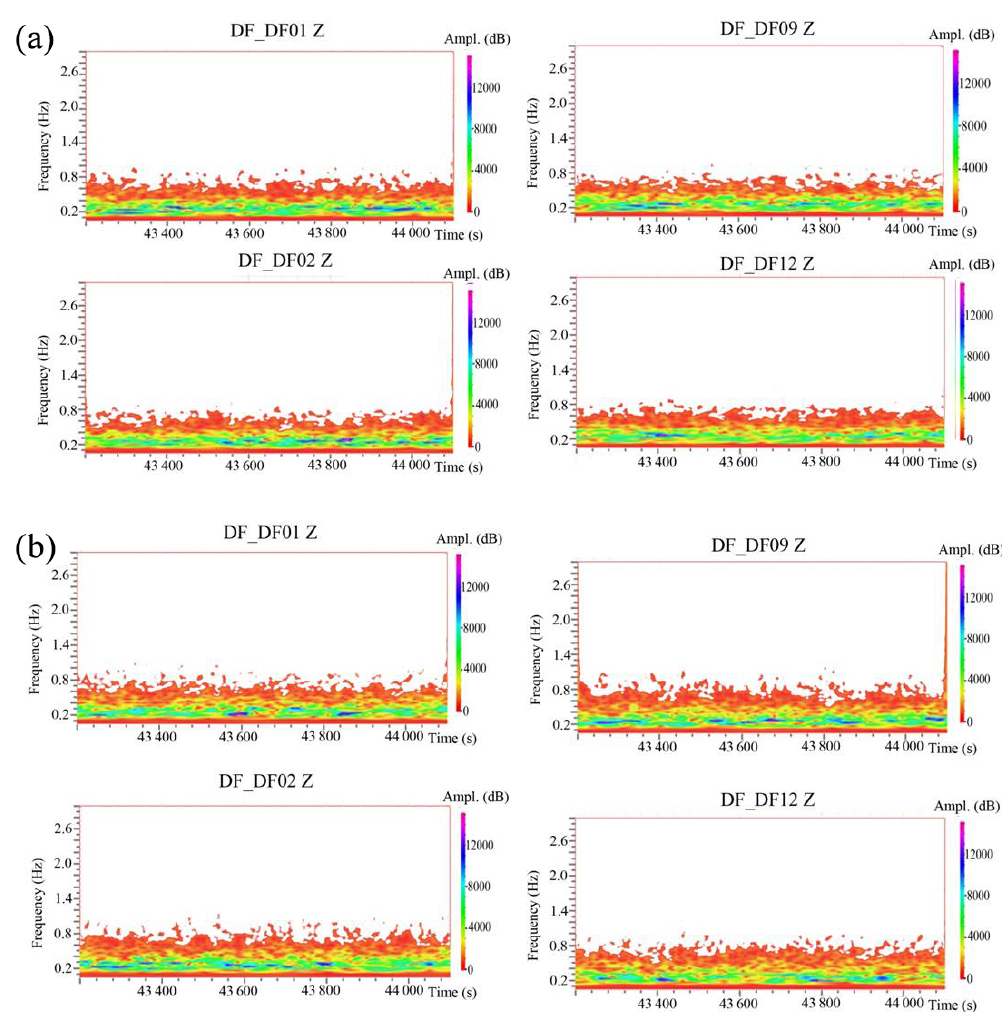
Figure 6. Examples of typical ambient noise spectrograms estimated for the low-frequency band (0.1–3Hz). (a) During weekend and (b) during the working